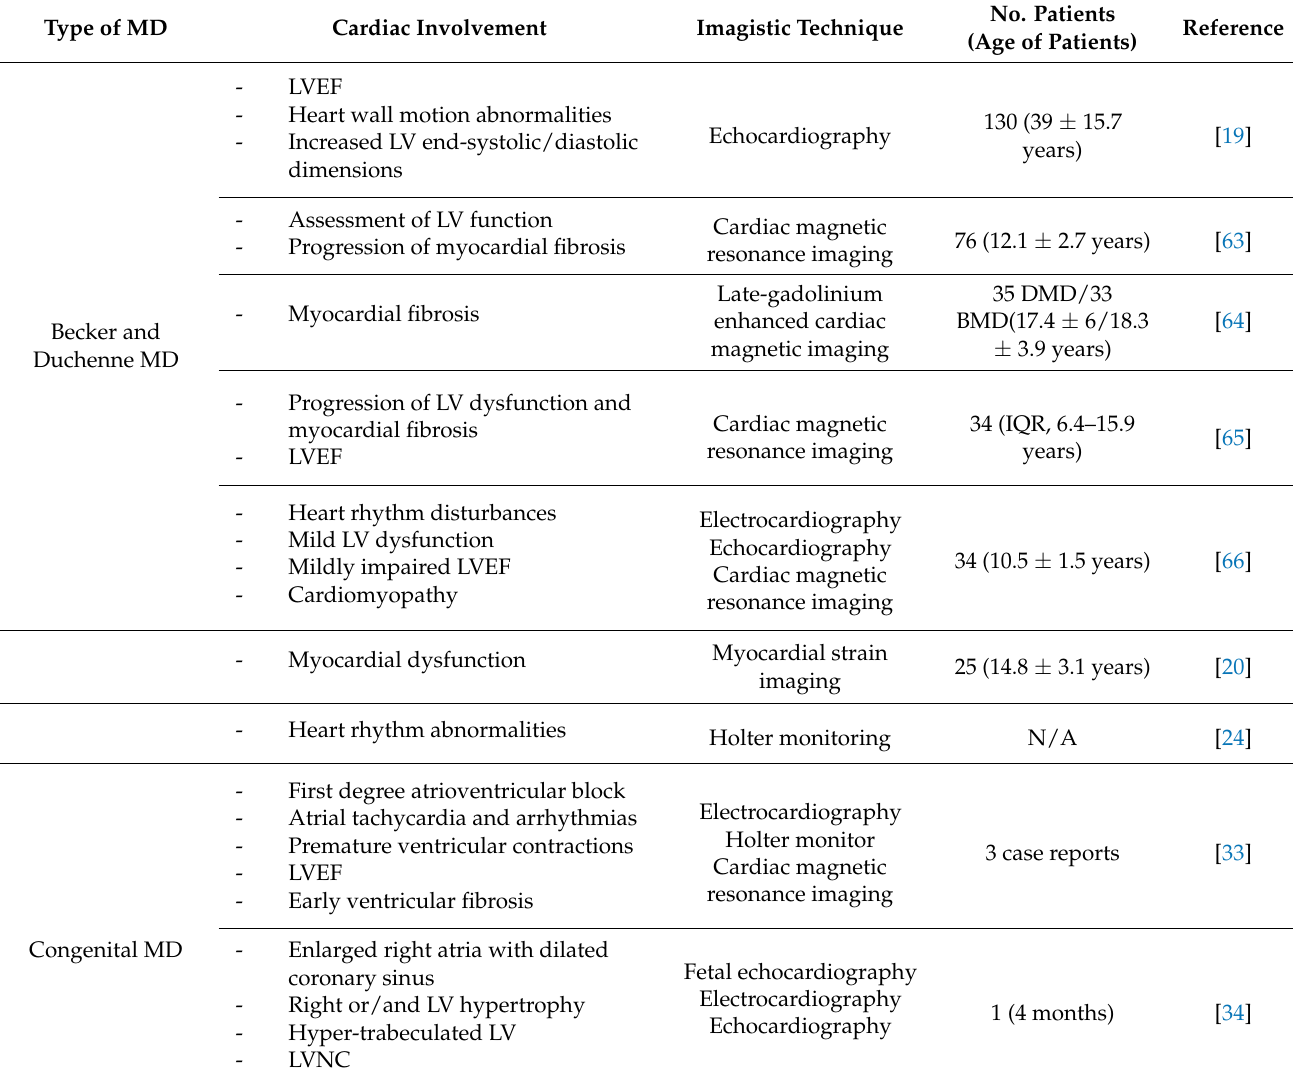
Table 1. Recent (last 3 years) research on cardiac involvement using cardiac imagistic